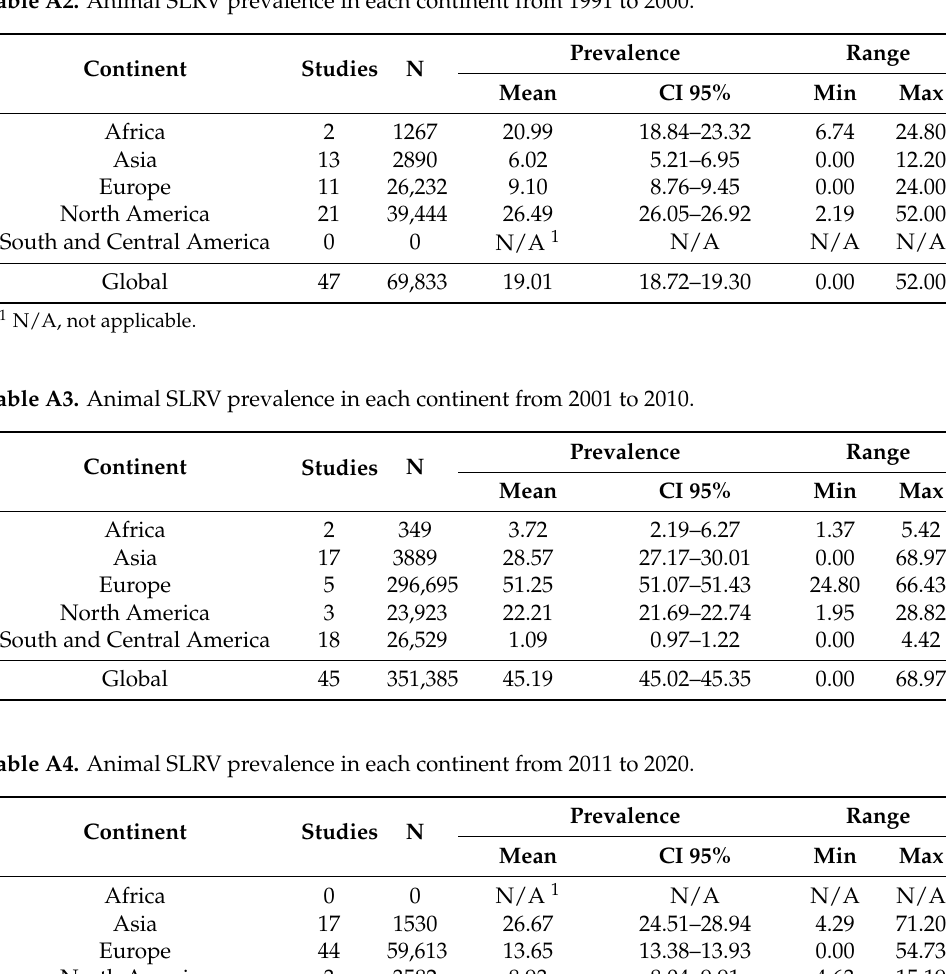
Table A2. Animal SLRV prevalence in each continent from 1991 to 2000.